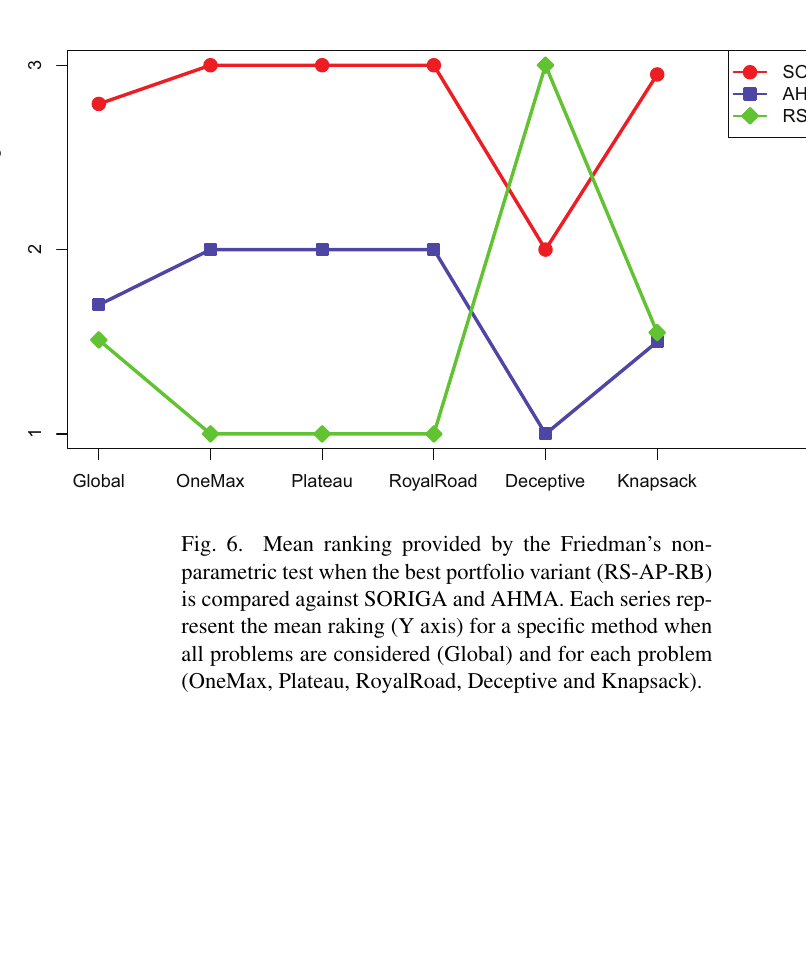
Algorithm portfolio based scheme for dynamic optimization problems